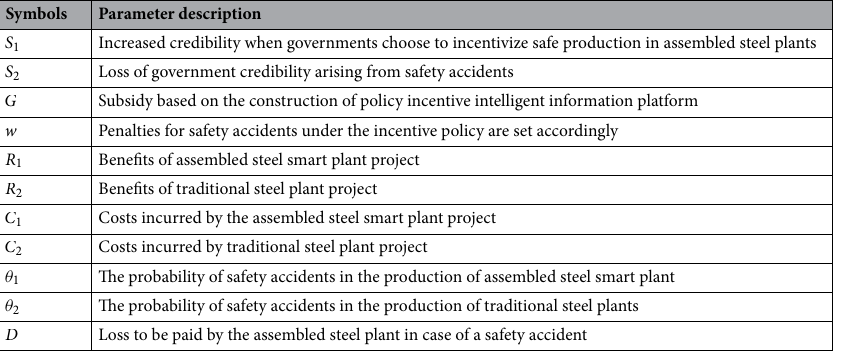
Symbols Parameter description